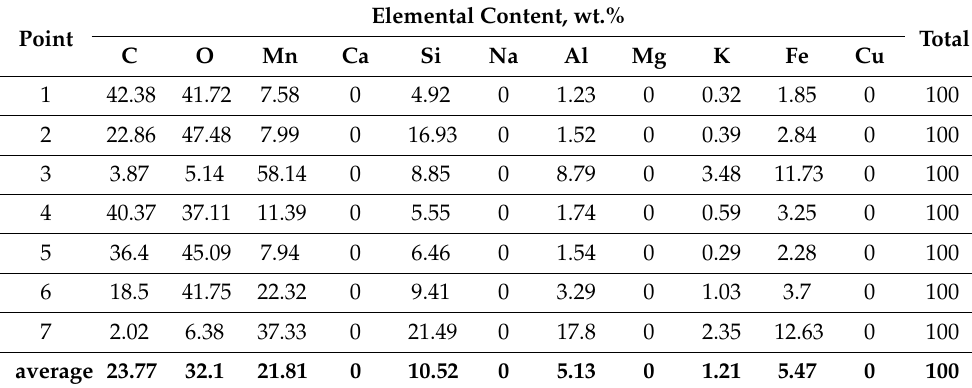
Table 2. Findings of the elemental analysis of Mn ore samples of the Zhaksy.